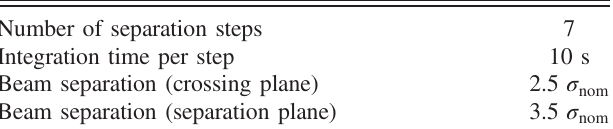
TABLE I. Scan parameters.